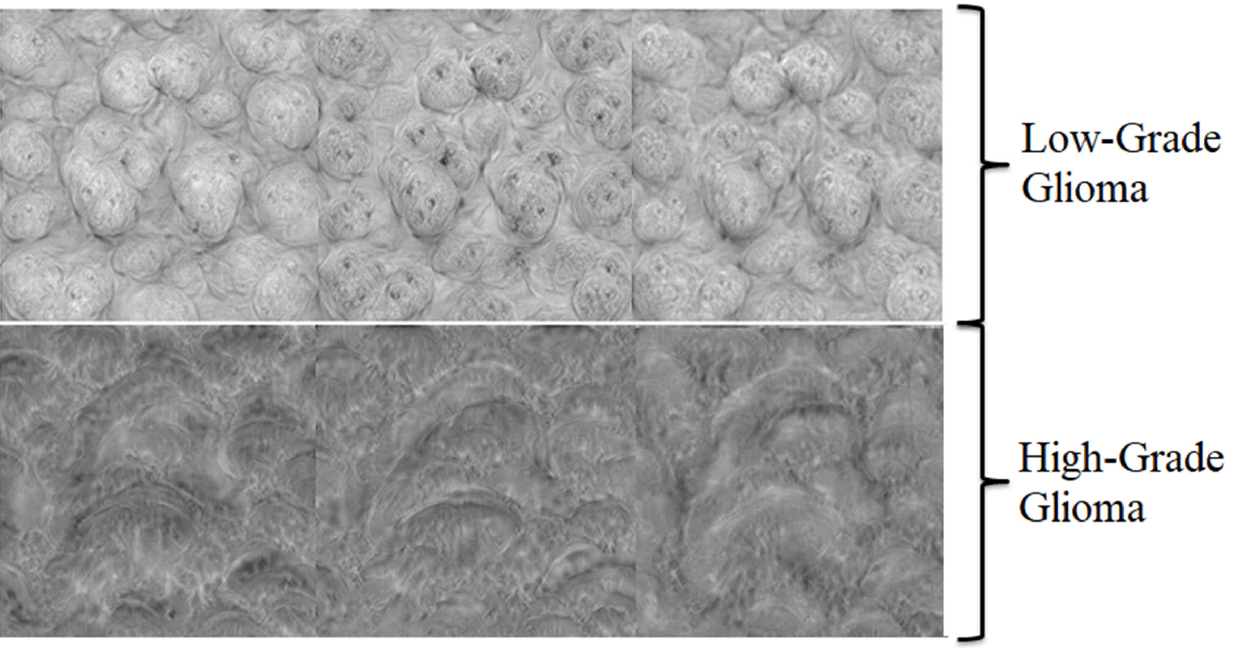
Figure A3. Confusion matrix of four rounds of the FLAIR-MRI dataset using the MajVot algorithm.